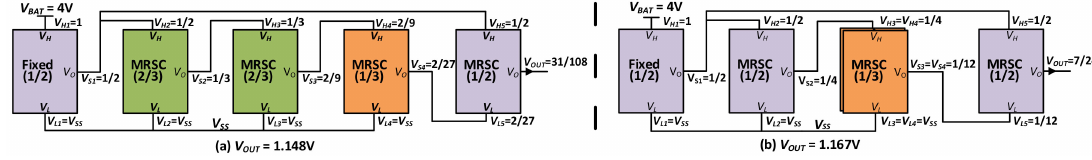
Figure 11. Figure 11 . Operation of reconfigurable SC converter at no load ( a ) V OUT = 1.148 V. ( b ) V OUT = 1.167